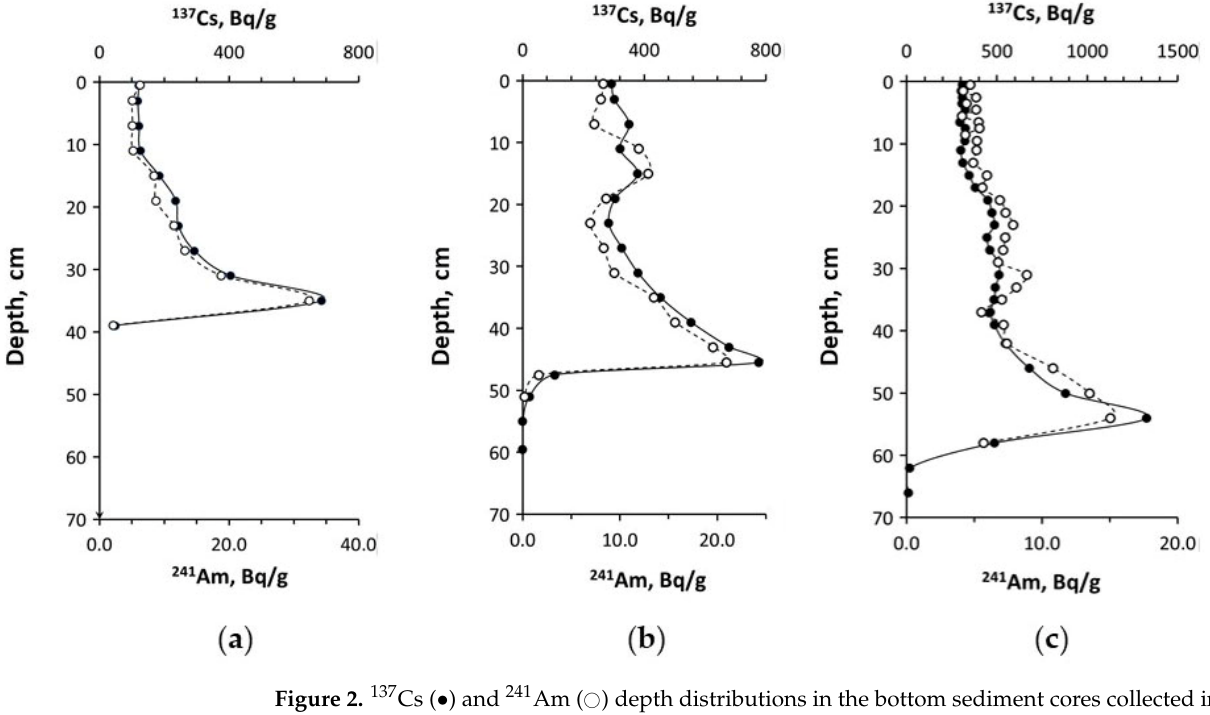
Figure 2. 137 Cs ( ● ) and 241 Am ( ○ ) depth distributions in the bottom sediment cores collected in the studied water bodies: ( a )—Lake Glubokoe, ( b )—Lake Azbuchin, ( c )—Chernobyl NPP cooling pond.